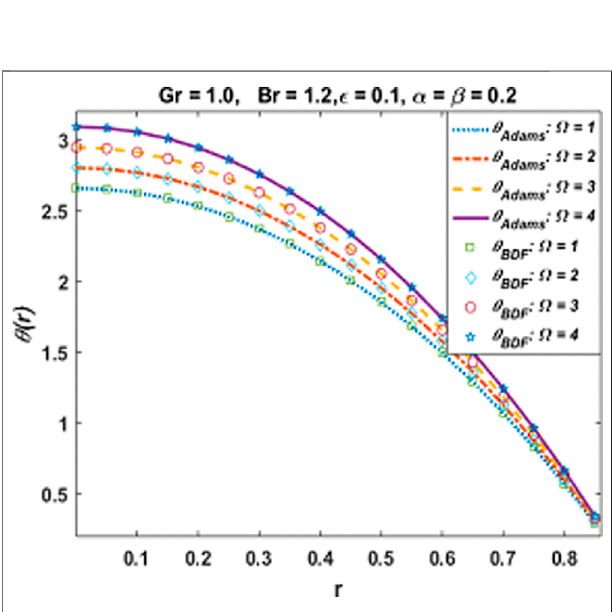
FIGURE 12 | Behavior of temperature pro fi le against Brinkman number.